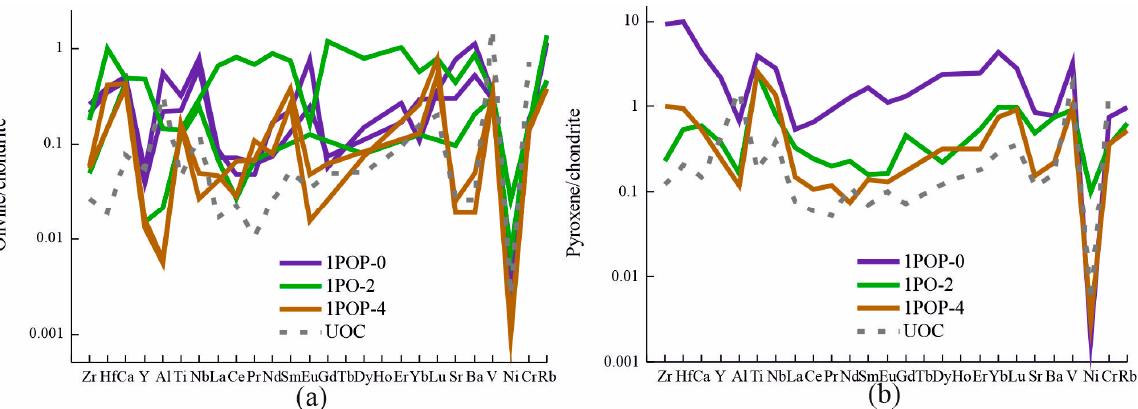
Figure 7. CI chondrite ‐ normalized trace element patterns of olivine ( a ) and pyroxene ( b ) from chondrules.